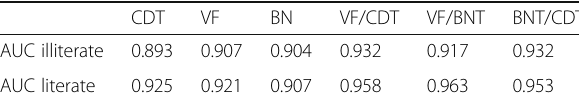
Table 6 AUC for single and combined tests in illiterate